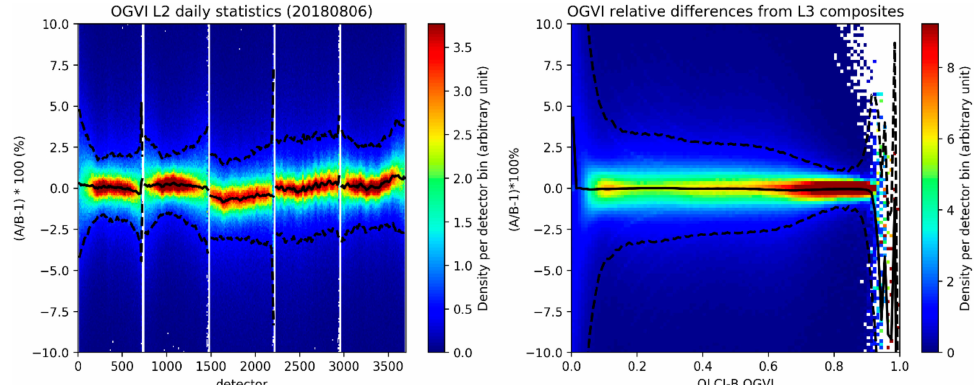
Figure 7. ( Left ): OGVI relative di ff erences of harmonised OLCI-A and OLCI-B over one day statistics (20180806). Results are shown as histograms per bin of OLCI detector. Medians and dispersions added in plain (resp. dashed) lines. ( Right ): the same but computed from all L3 composites over the tandem period. Results are shown as histograms per value of OGVI with OLCI-B taken as reference. From the L3 comparisons, OGVI mean (resp. median) relative di ff erence between OLCI-A and OLCI-B are found to be 0.7% (resp. 0.0%), which is much better than the accuracy specifications.